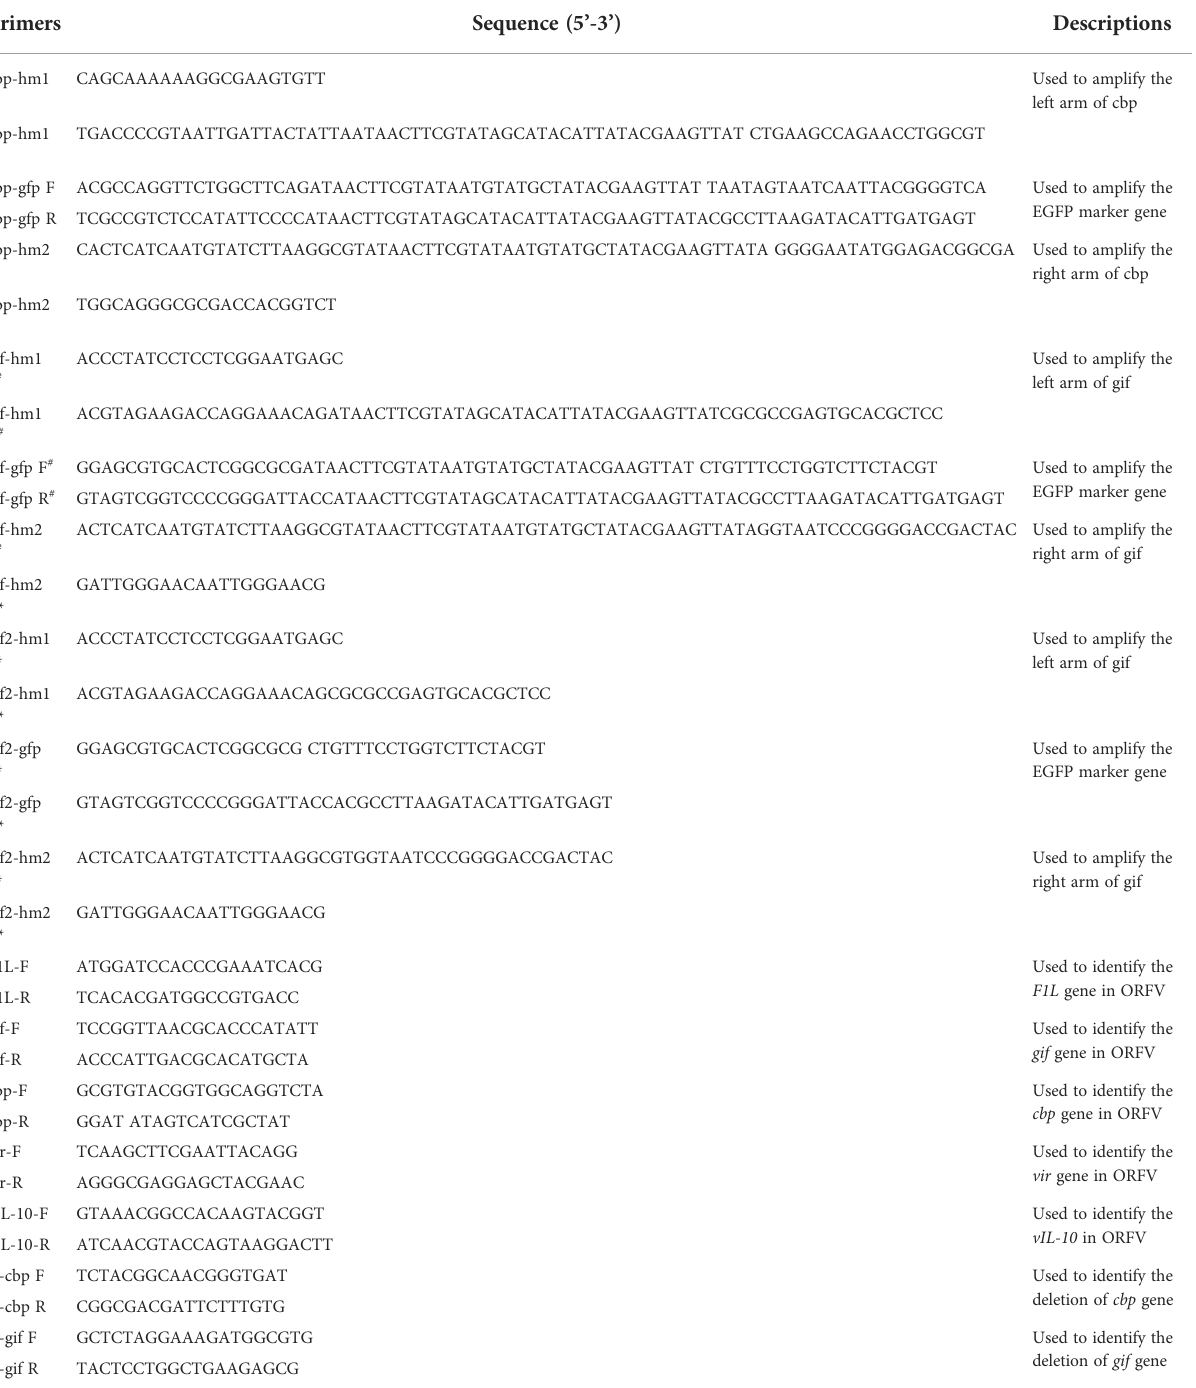
TABLE 1 Primers used to generate and identify the recombinant